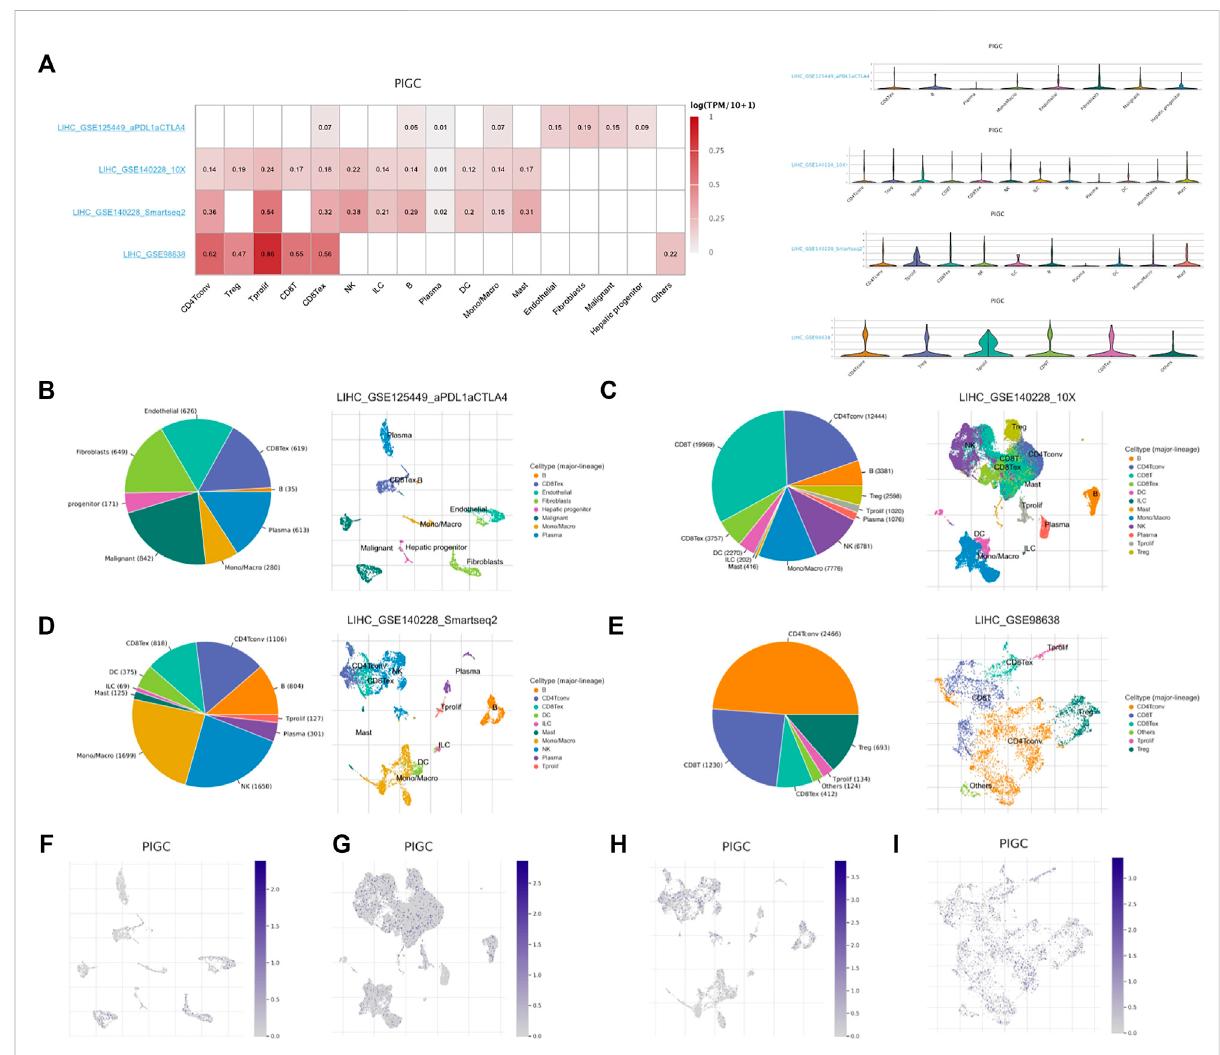
FIGURE 7 Correlation between PIGC and the tumor immune microenvironment using TISCH. (A) Average expression of PIGC in different cell types, and the distribution of PIGC expression in different cell types using violin plot. (B – E) The cell types and their distribution in LIHC_GSE125449,